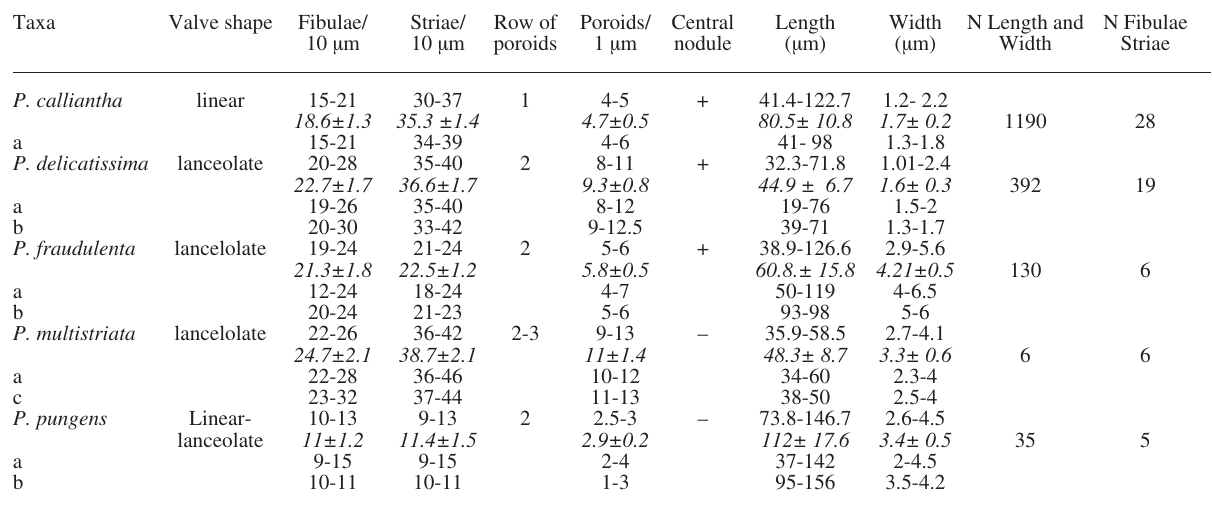
Table 1. – representative morphological characteristics observed for nW Mediterranean Pseudo-nitzschia species from field samples compared with literature data. a hasle (1995), priisholm et al. (2002), lundholm et al. (2003). b Kaczmarska et al. (2005), c orsini et al. (2002). numbers in italic show mean ± Sd. all measures were done with SeM. n= number of observation.